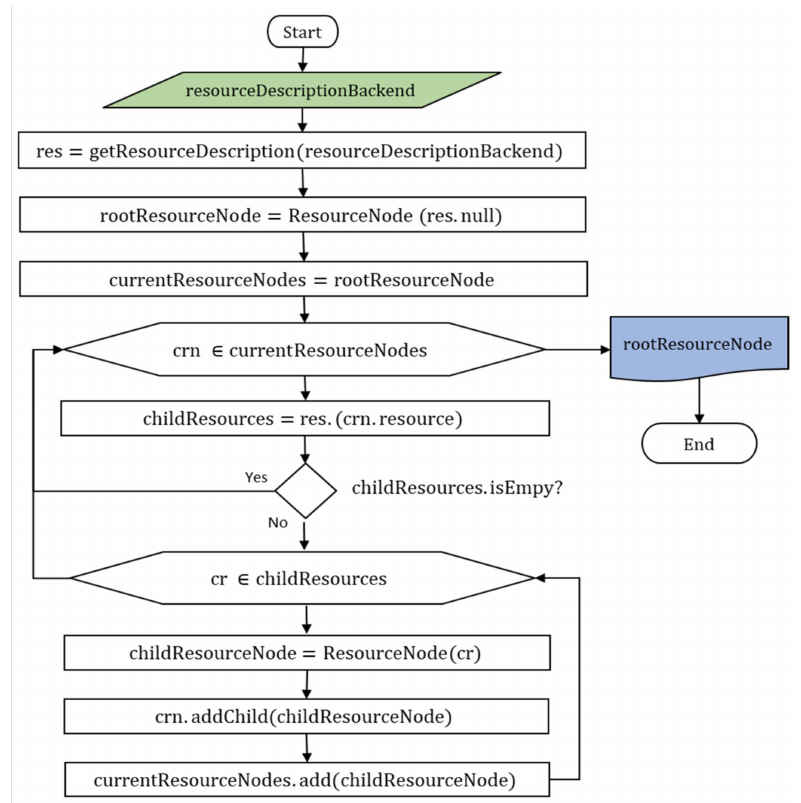
Figure 9. Resource Tree Initialization Algorithm Flow